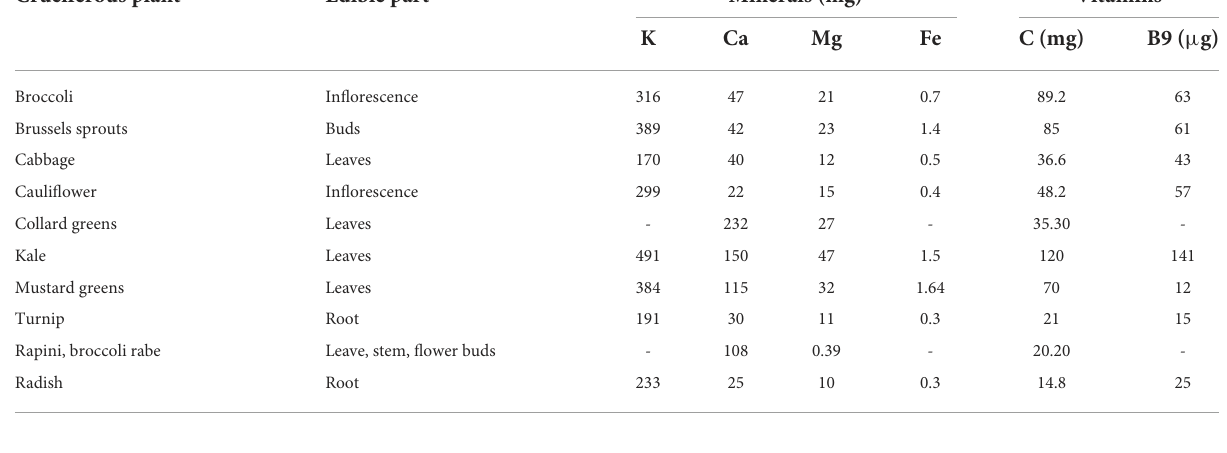
TABLE 2 Micronutrients of cruciferous vegetables per 100g. Cruciferous plant